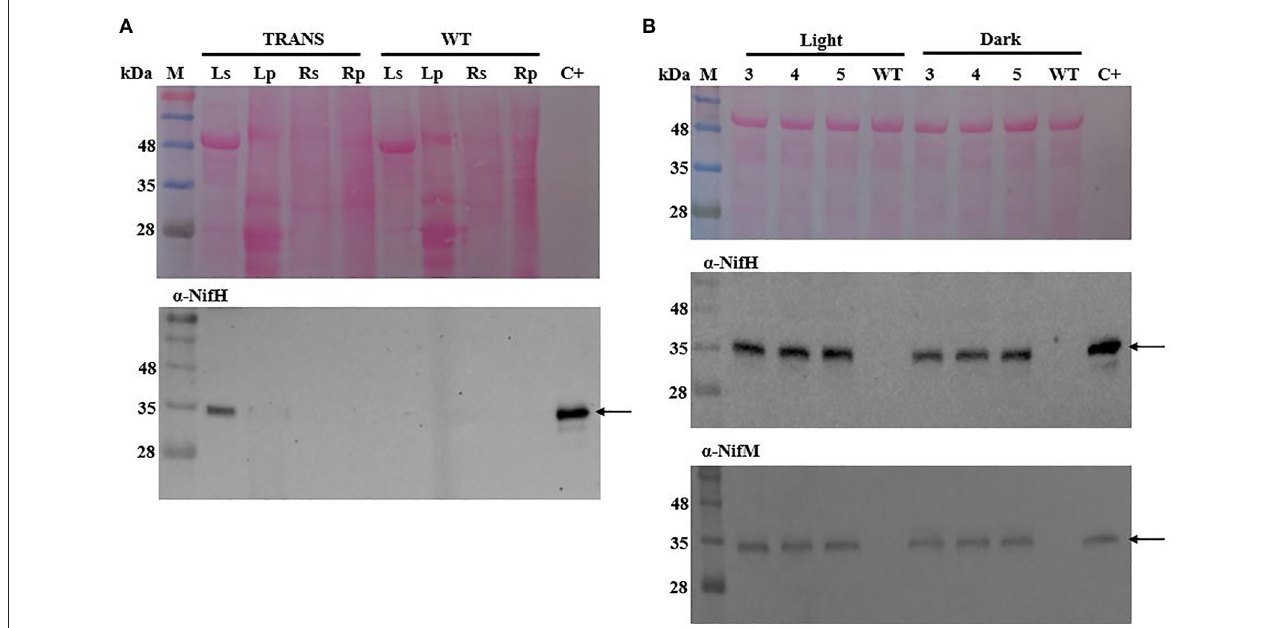
FIGURE 1 | Immunoblot analysis of NifH and NifM polypeptide accumulation in transplastomic tobacco. (A) NifH accumulation in soluble (s) or membrane-associated pellet (p) fractions from leaf (L) and root (R) tissues of transplastomic (TRANS) or wild-type (WT) tobacco. (B) Accumulation of soluble NifH and NifM in leaves of transplastomic tobacco harvested during light or dark periods at three (3), four (4) and five (5) weeks after sowing. Arrows point to polypeptides detected with antibodies against the A. vinelandii NifH and NifM proteins. C + , pure A. vinelandii NifH and NifM proteins; M, molecular mass markers (kDa); WT, total protein extract from 4-week-old WT tobacco leaves. Ponceau staining of membranes are shown as control of protein loading and